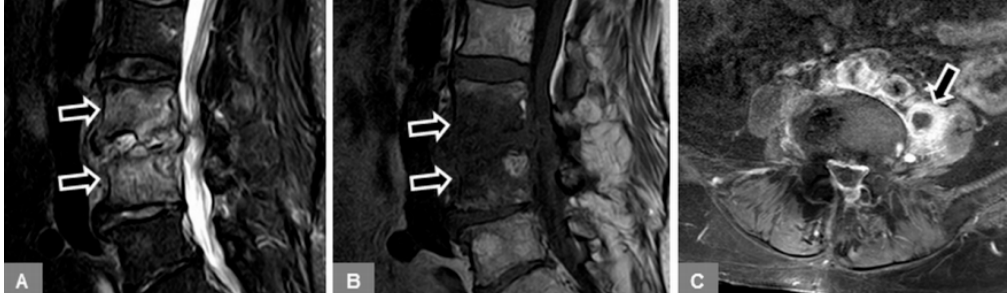
Figure 3. Advanced spondylodiscitis. A 79-year-old female patient with vertebral bone marrow edema on a sagittal STIR image at L3/L4 ( A , arrows), with vertebral endplate destruction on a sagittal T1-w image ( B , arrows), and left-sided, rim-enhancing psoas abscess formation on a transverse T1-w contrast-enhanced, fat-suppressed image ( C , arrow).